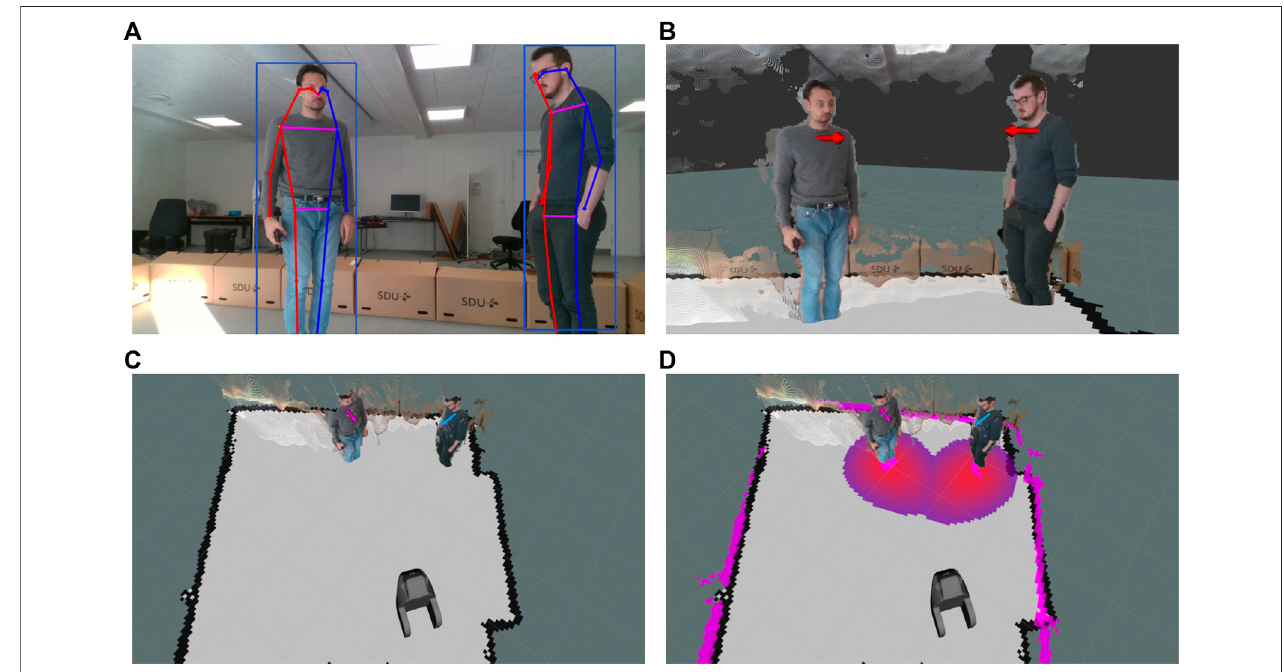
FIGURE6| Visualizationofthehumanposedetectionmoduleandthetracking-by-detectionmodulewithcostassociation: (A) outputofthehumanposedetection network; (B) estimated torso position and facing direction; (C) assigned labels by the tracker (visualized with differing colors of the torso marker); (D) costmap with cost gradients assigned to each